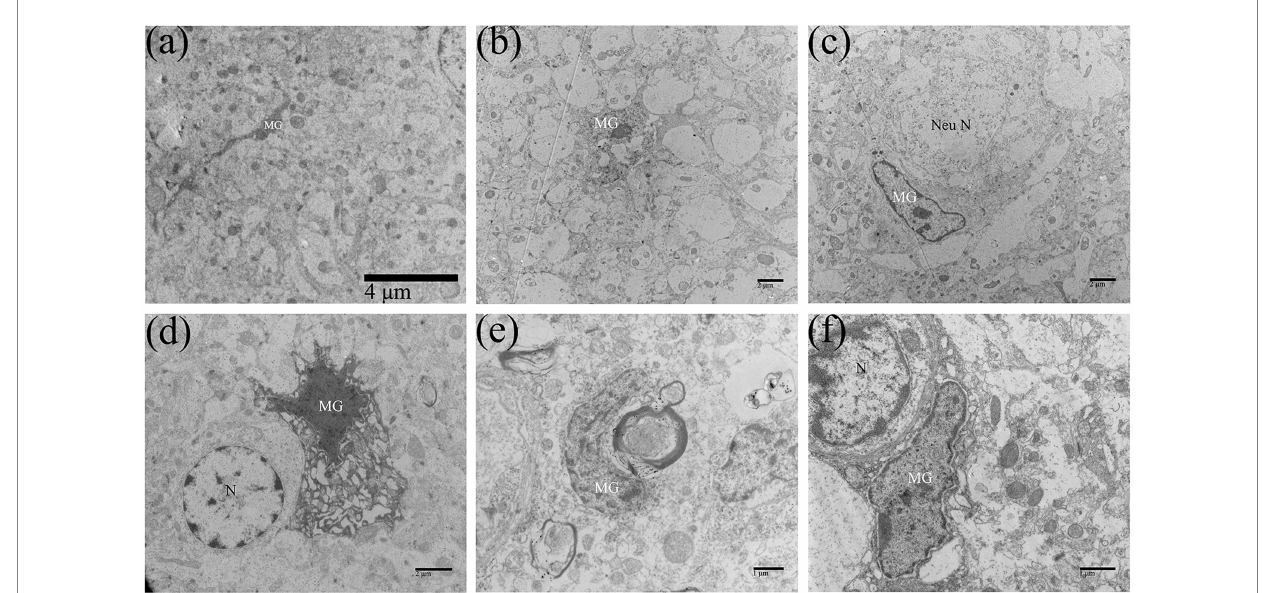
FIGURE 6 Microglia were activated in DTMUV-infected duckling brains. (A) The resting microglia. (B) The activated microglia. (C) The microglia was phagocytizing the damaged neuron. (D) The microglia was phagocytizing the damaged astrocyte. (E) The microglia was phagocytizing the damaged myelinated